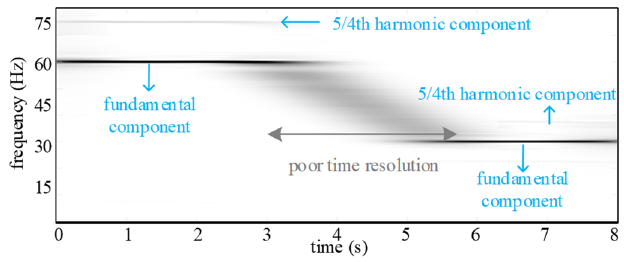
Figure 13. Experimental result using Gabor transform when σ = 0.5.